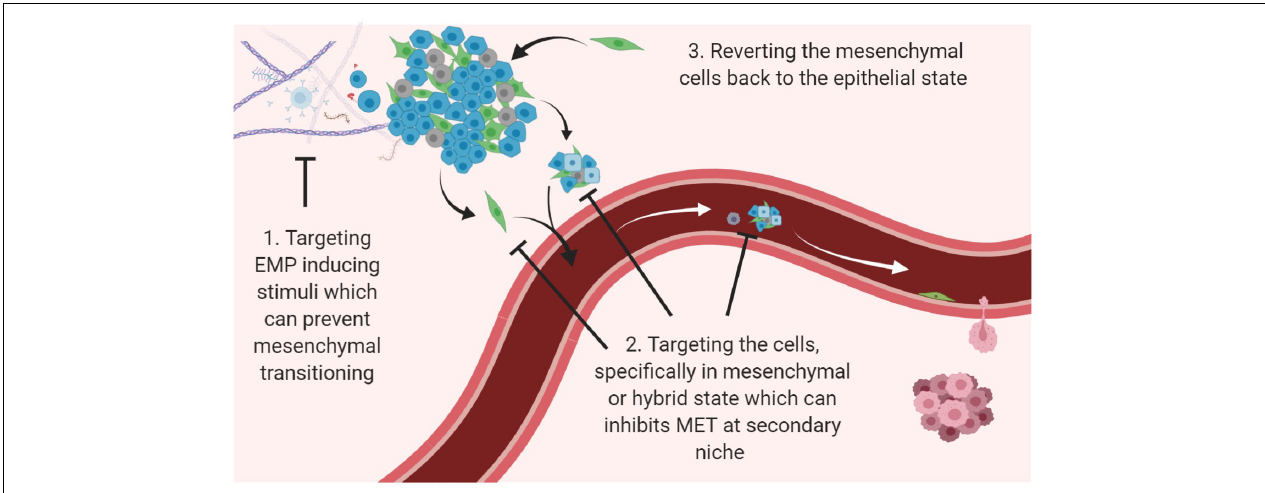
FIGURE 2 | Potential avenues to target EMP. Three main strategies for targeting cancer progression and recurrence with relevance to EMP dynamics are to use agents/compounds (i) that can target the inducers to prevent EMT; (ii) that can selectively kill mesenchymal phenotype and cells present within multiple transition states; (iii) that can revert the cells via